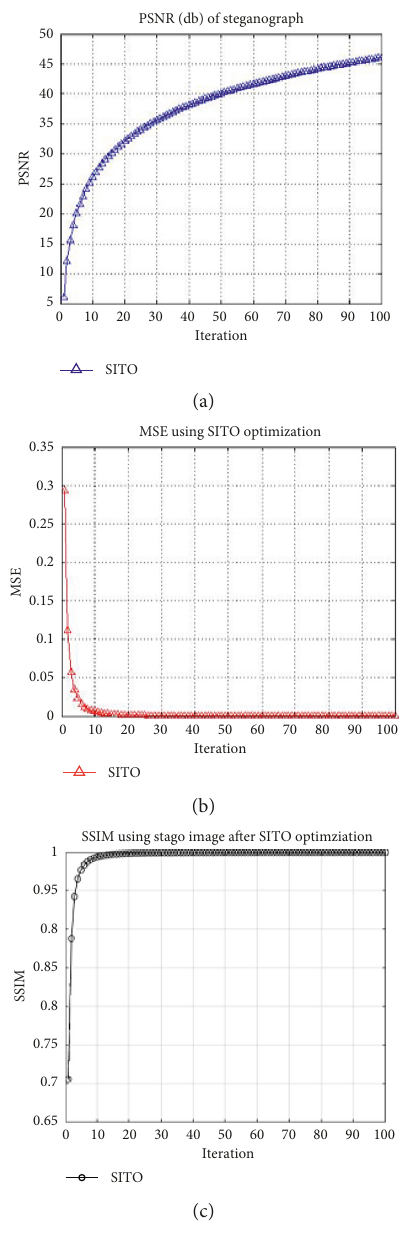
Figure 5: (a) PSNR, (b) MSE, and (c) SSIM